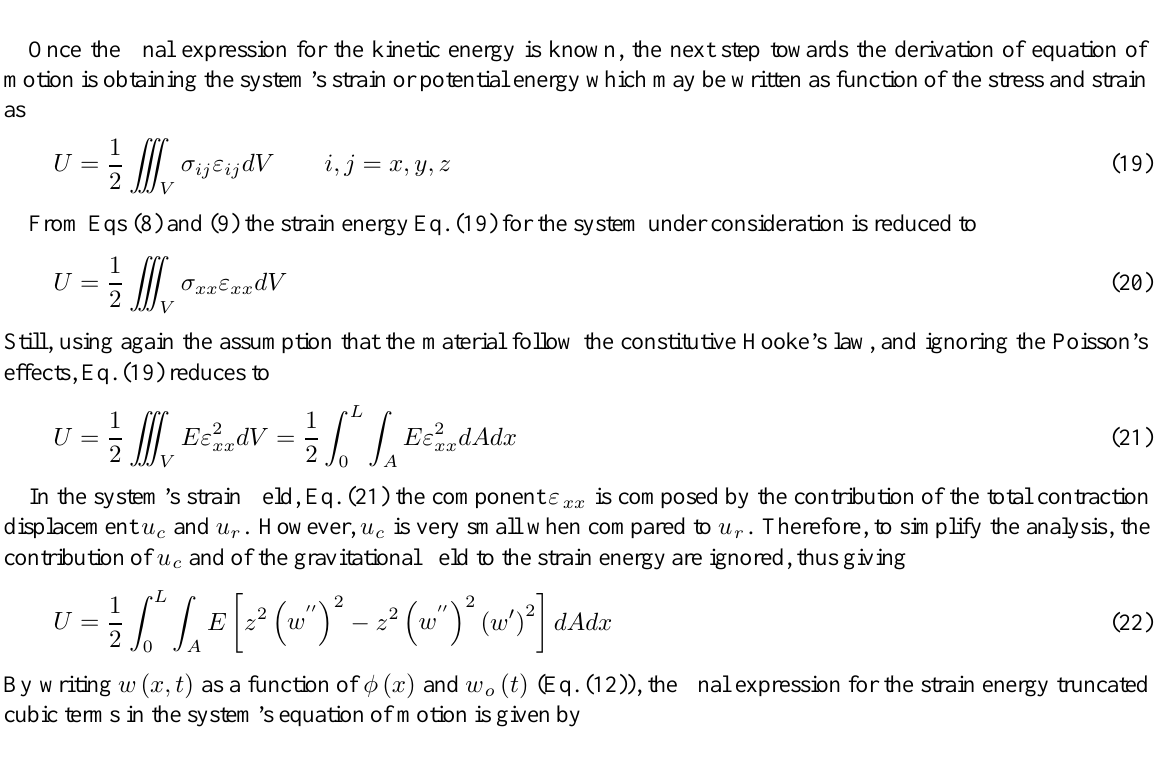
Fig. 7. Experimental result showing angular acceleration exhibited by the exciter